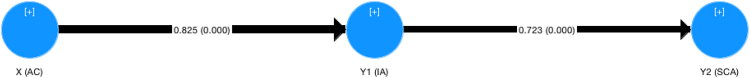
Structural model evaluation.